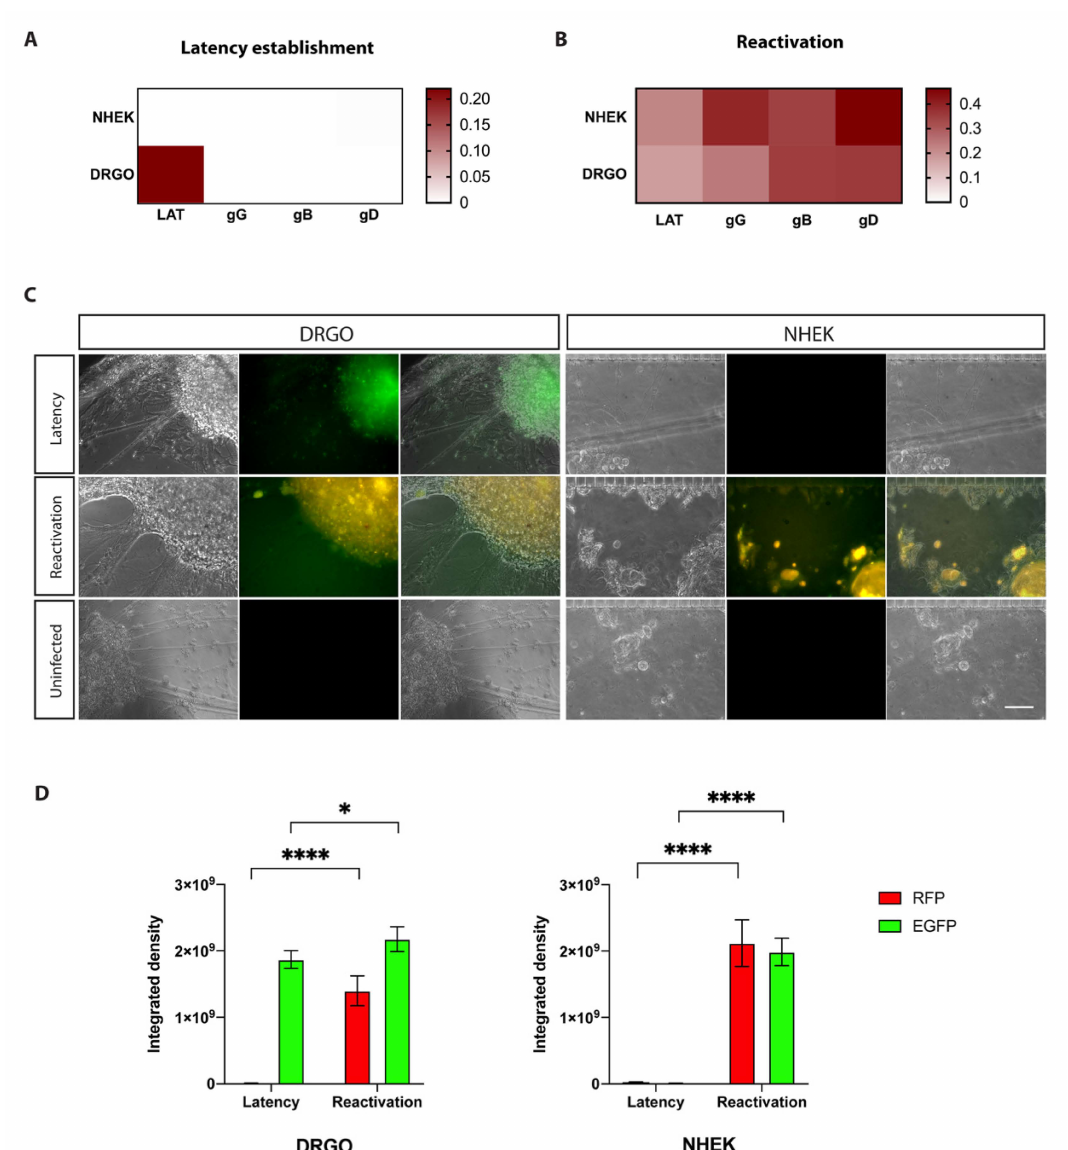
Figure 6. Anterograde virus spread experiment (EXP #1). Virus gene expression profiling for HSV-1 latency establishment ( A ) directly in DRGOs. Organoids were infected and latency was obtained through ACV addition to the culture medium. Thermal stress led to controlled reactivation ( B ), and anterograde transport of virus particles resulted in NHEK lytic infection. ( C ) Live imaging of DRGOs and NHEKs showing recombinant HSV-1 during latency (pICP0 active, green) and reactivation (pICP0 and pgC active, yellow). Scale bar, 100 µ m. ( D ) Levels of ICP0 (green fluorescent signal) and gC (red fluorescent signal) expression measured as integrated density values for DRGOs and NHEKs, during latency and reactivation. Mean ± SD, * p < 0.05, **** p < 0.0001, n = 6 independent experiments (12